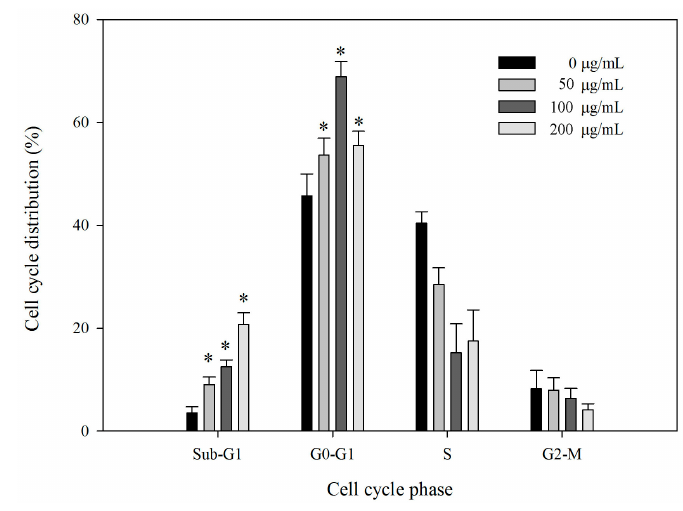
Figure 6. BEPS-IA induced cell cycle arrest in HepG2 cells. Cells were cultured for 24 h with BEPS-IA (50, 100 and 200 μ g/mL, respectively). Bar graph summarizes the data on cell cycle distribution from three independent experiments. Values marked with * are significantly different compared to the control ( p < 0.05).